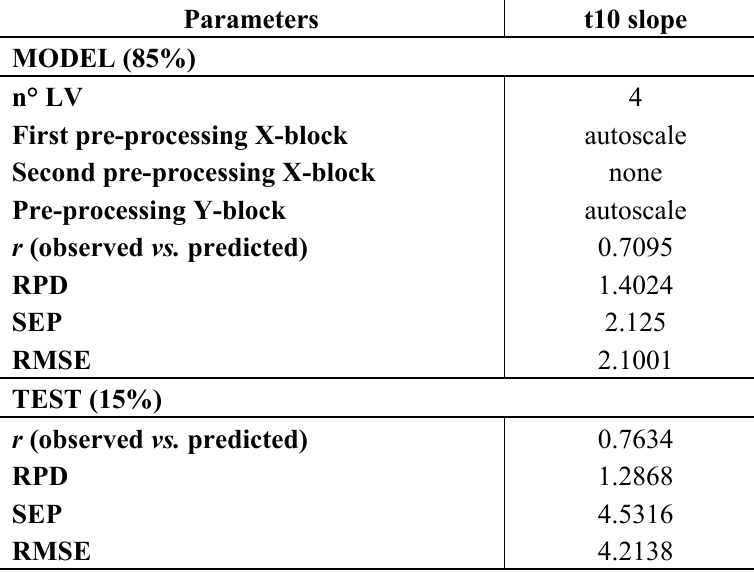
slope. In the 10